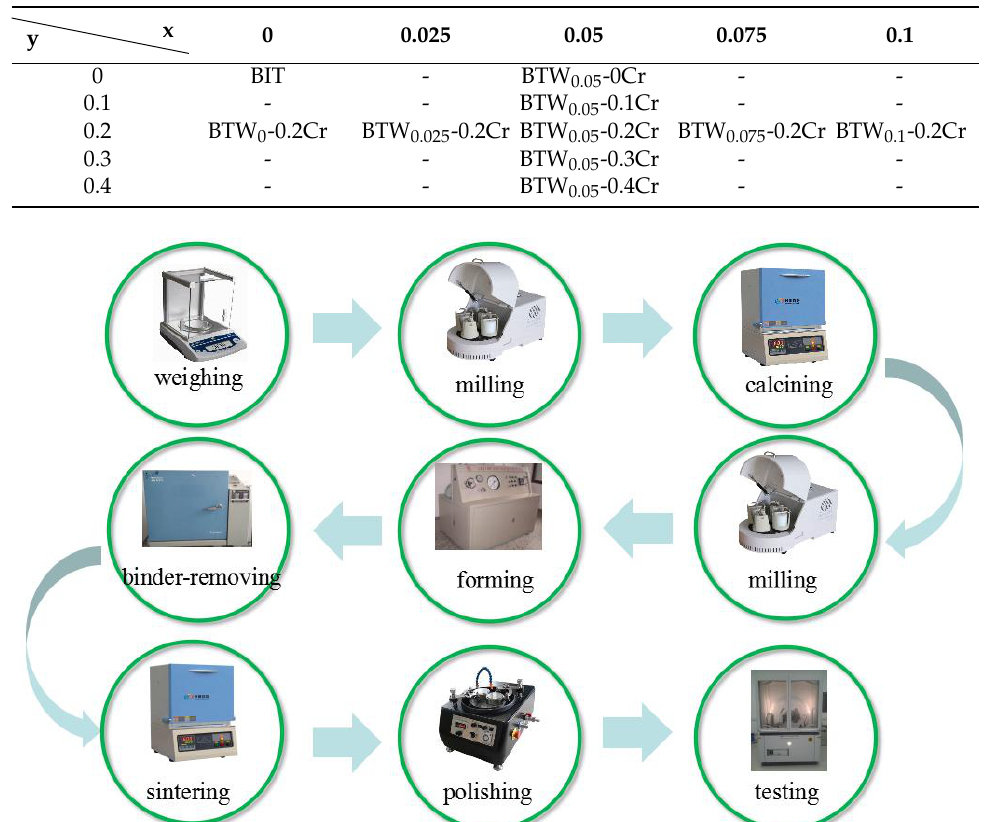
Composition design and sample number of Bi 4 Ti 3 − x W x O 12+x + y wt % Cr 2 O 3